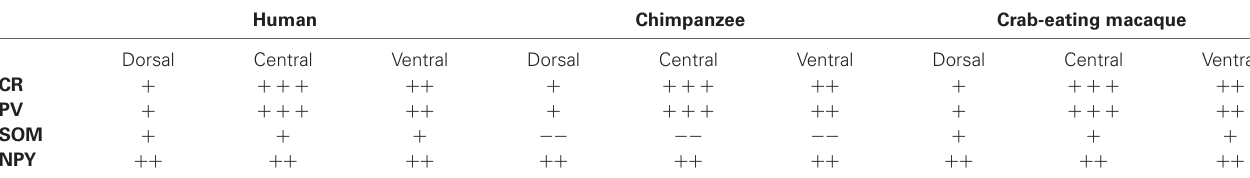
Table 2 | CR and PV neuronal density in the human, chimpanzee, and crab-eating macaque claustrum (count of labeled cells per mm 2 ). CR PV mm 2 Chimpanzee